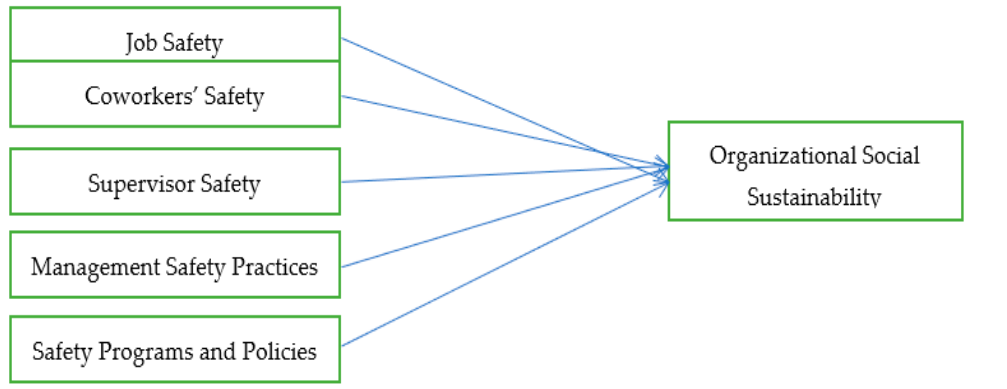
Figure 1. Schematic view of research model.